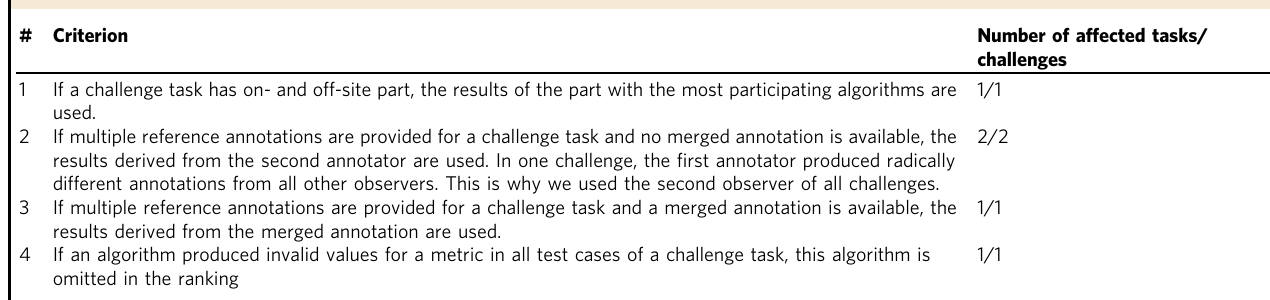
Table 2 Inclusion criteria on challenge level